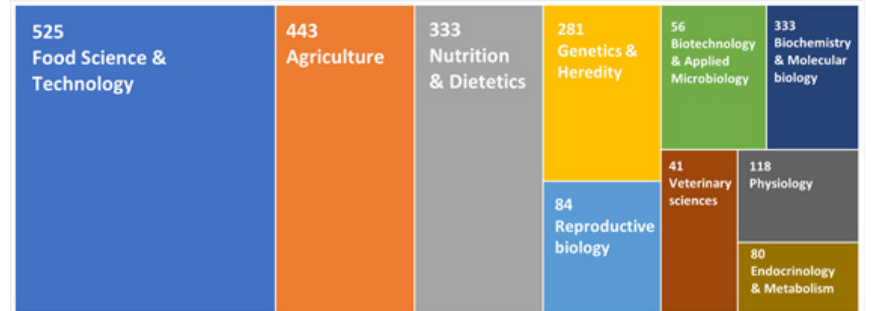
Figure 3. TreeMap chart of the most important research areas for the A2 β -casein field. The absolute number of publications referring to A2 β -casein in each research area is indicated. The areas of the chart are proportional to the number of publications with respect the total number of publications of each research area. Only the 10 most important areas in relative terms are shown.